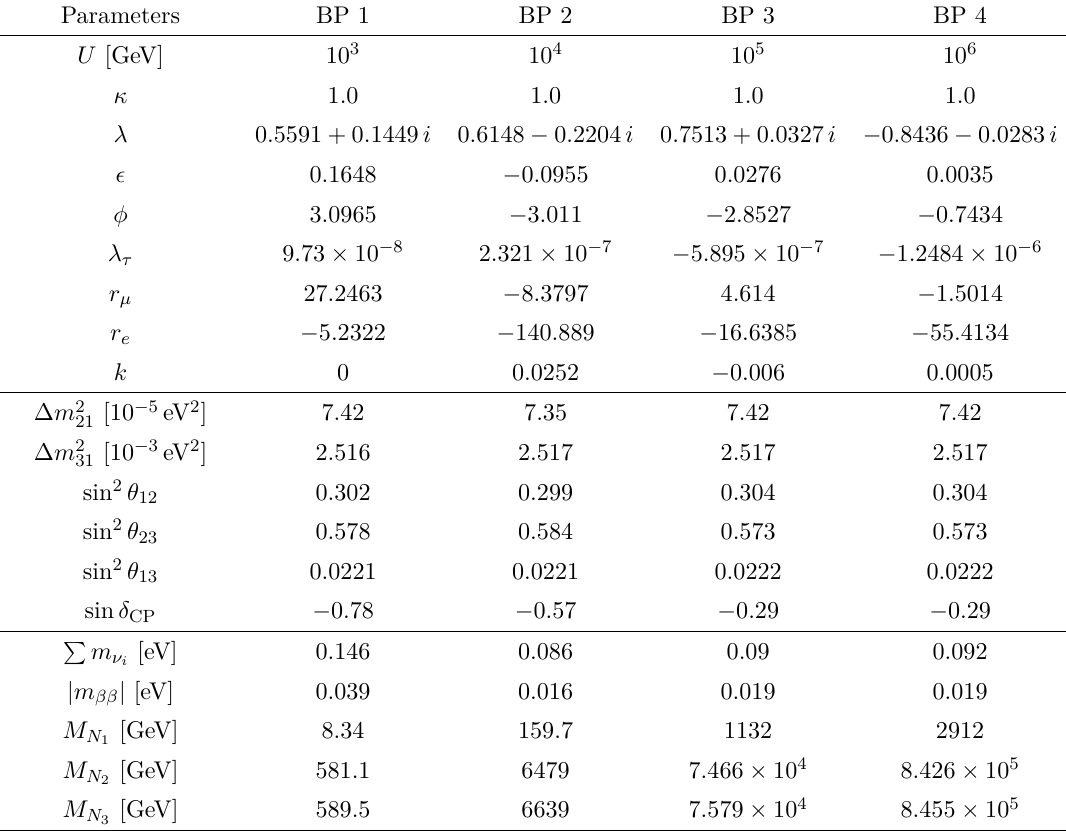
Table 1 . The best fit values of model parameters, corresponding results for neutrino masses and mixing observables and relevant predictions for four benchmark solutions obtained for κ = 1 and different values of U